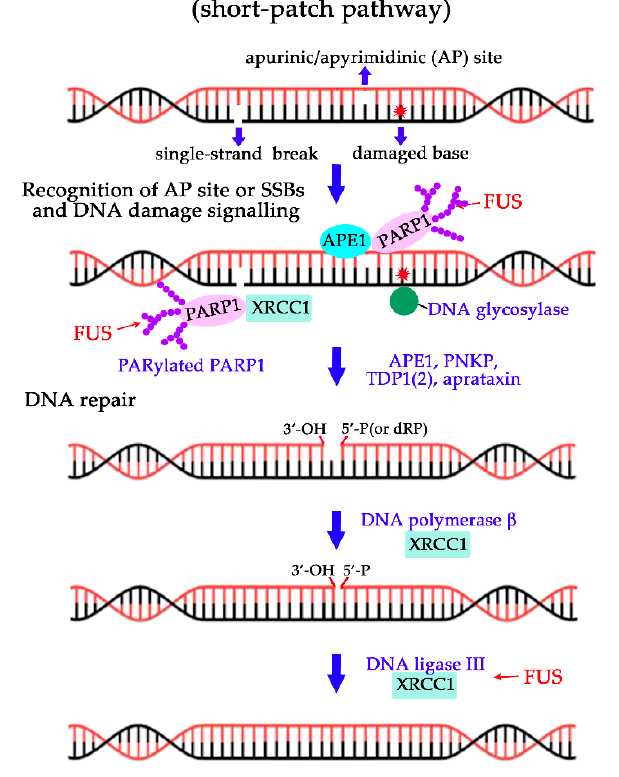
Figure 4. The involvement of FUS in base excision repair (BER) or single-strand break (SSB) repair pathways. Simplified scheme for BER/SSBR short-patch pathway [87]. Monofunctional DNA glycosylases catalyse the removal of the damaged base through cleavage of the C1’-N -glycosylic bond, leaving an AP site. AP endonuclease1 (APE1) cleaves AP site, DNA polymerase β inserts a single nucleotide and removes the 5 ′ -deoxyribose phosphate (dRP), and the resulting nick is sealed by DNA ligase III-XRCC1 complex. In the case of SSB, the 5 ′ -and 3 ′ -termini containing blocking modifications can be converted to 5 ′ -phosphate (P) and 3 ′ -hydroxyl (OH) moieties by APE1, polynucleotide kinase 3’-phosphatase (PNKP), tyrosyl-DNA phosphodiesterase 1/2 (TDP1, TDP2) and/or aprataxin. AP sites, SSBs, arising endogenously or exogenously are bound by PARP1, which is then activated and autoPARylated. AutoPARylated PARP1 recruits repair proteins, in particular XRCC1 to the SSB [87]. The impact of FUS on BER is as follows: FUS interacts with PARylated PARP1 and the DNA ligase III–XRCC1 complex, thereby stimulating the ligation of DNA ends [40].